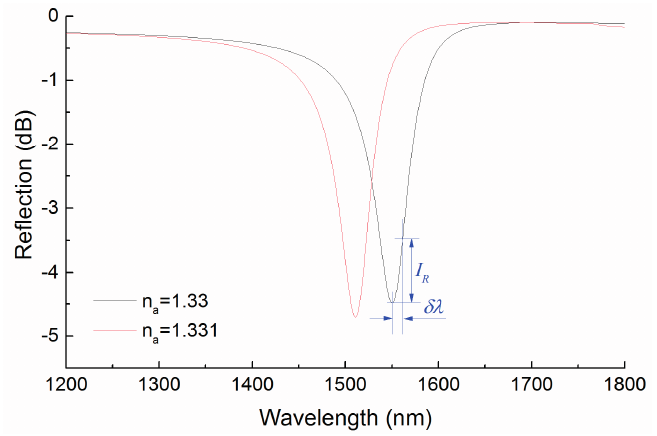
Figure 13. The wavelength interrogation curve for the bimetallic SPR curve with 3 nm Au over 32 nm